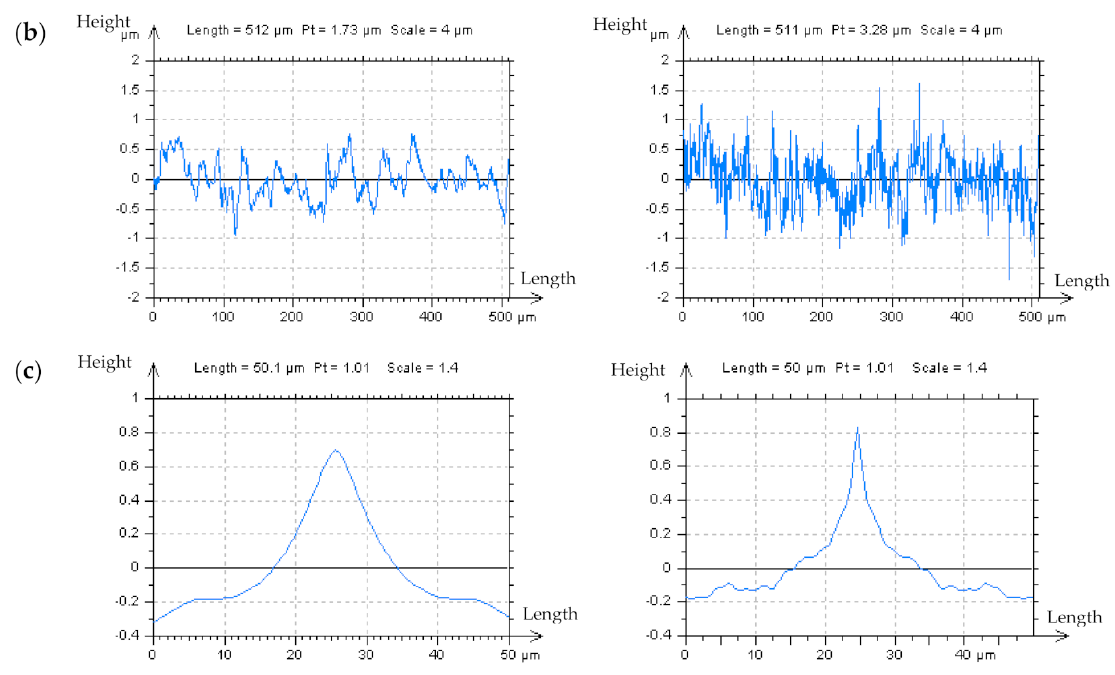
Figure 10. The contour map plots of turned surfaces and their ISO 25178 [86] parameters ( a ), extracted TTPs ( b ) and their ACFs ( c ) of instrument topographies, measured by a stylus method with a speed of 1 mm/s and after adding a modelled noise with Sq equal to the 30% to the Sq of analyzed surface texture, respectively (from left to right